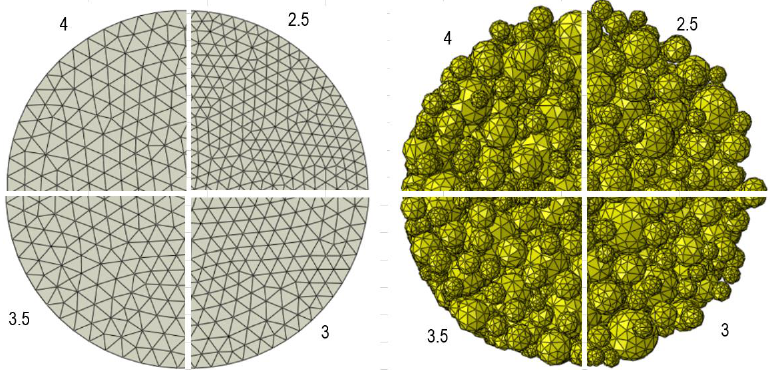
Figure 5. Different mesh sizes used. ( left ) Top view of the cylinder. ( right ) Top view of the coarse aggregate particles.